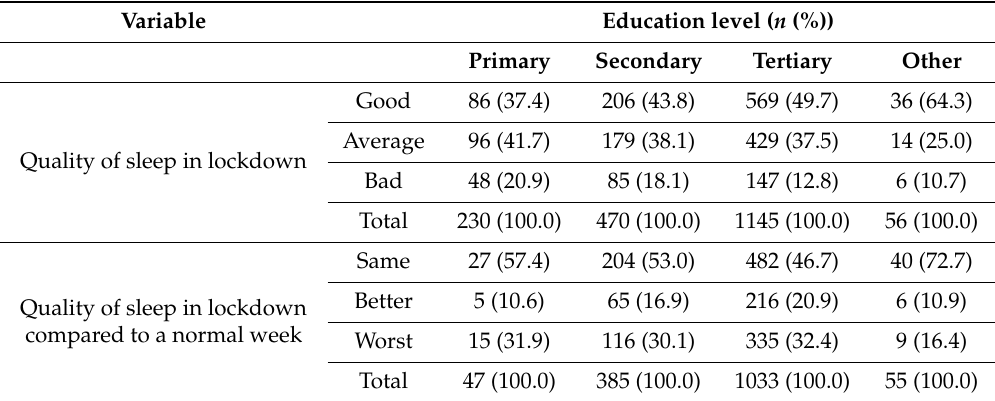
Table 2. Quality of sleep and change in quality of sleep from normal to lockdown by education